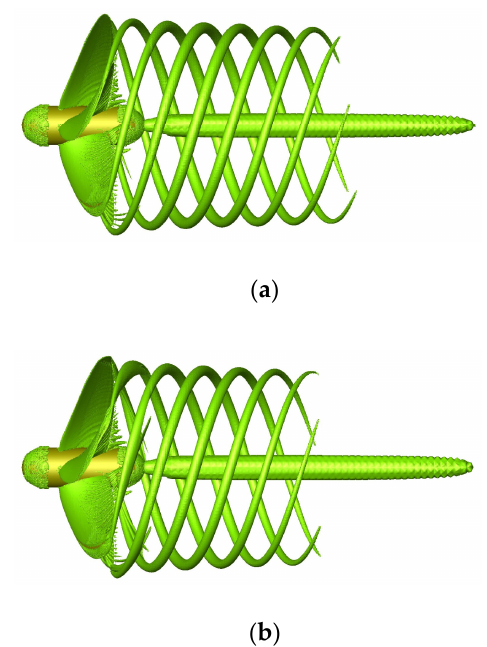
Figure 19. Iso-surface of Q = 2.0 × 10 4 1 / s 2 at J = 0.6: ( a ) benchmark propeller and ( b )